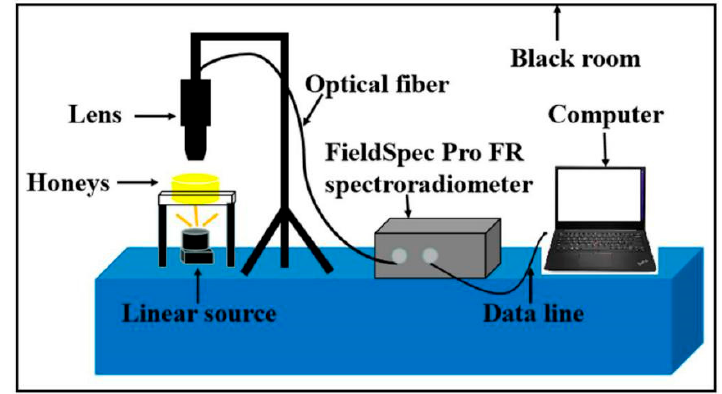
Figure 6. The configuration of the Vis/NIR spectroscopy imaging system. The probe receives the spectral information and transmits it to the spectrometer through the optical fiber. The spectrometer transmits the spectral information to the computer through the data line.